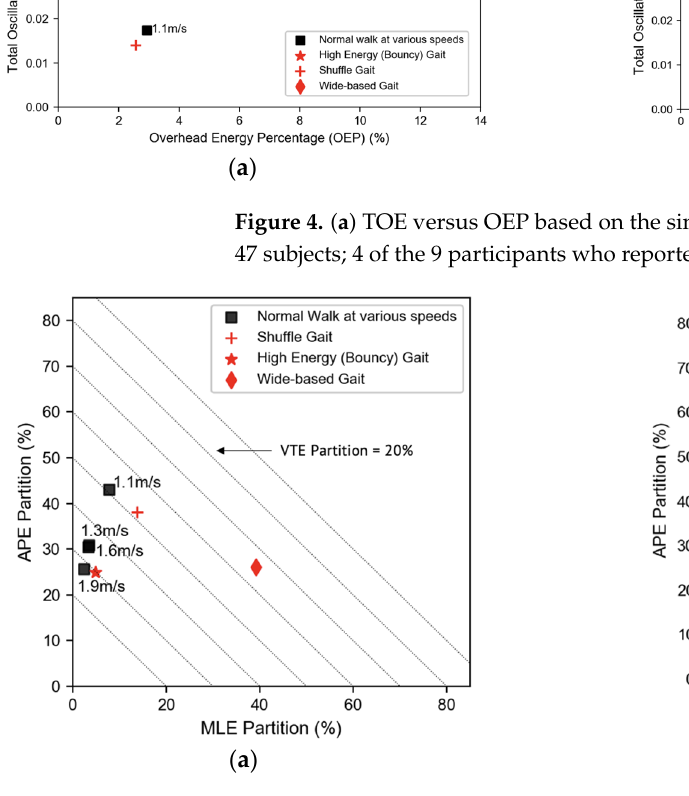
Figure 5. ( a ) Energy Partitioning graph of the single subject. ( b ) The EP graph of 47 subjects; 4 of the 9 participants who reported underlying health conditions are highlighted.